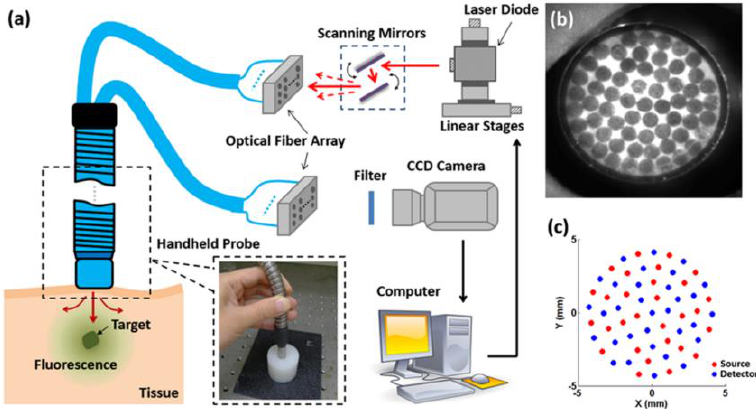
Figure 1. ( a ) Schematic of the FMTPen system; ( b ) photograph of the end face of FMTPen; and ( c ) corresponding arrangement of the sources (red) and detectors